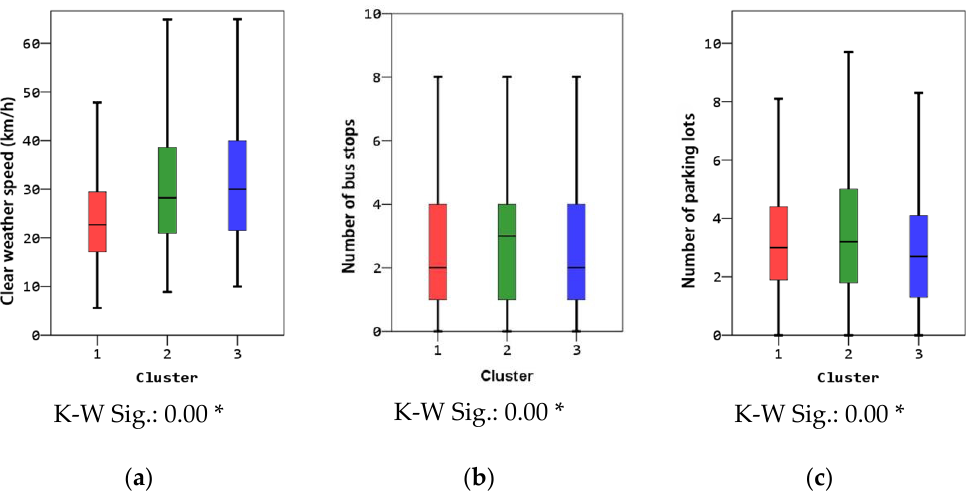
Figure 9. Box plots of three indicators. ( a ) Traffic speeds in no rain days; ( b ) bus stops; ( c ) parking lots. Note: The results of the K–W test (K-W Sig.: 0.00 *) show that at least one cluster is significantly different from one other cluster in terms of all indicators (SI ≤ 0.001).